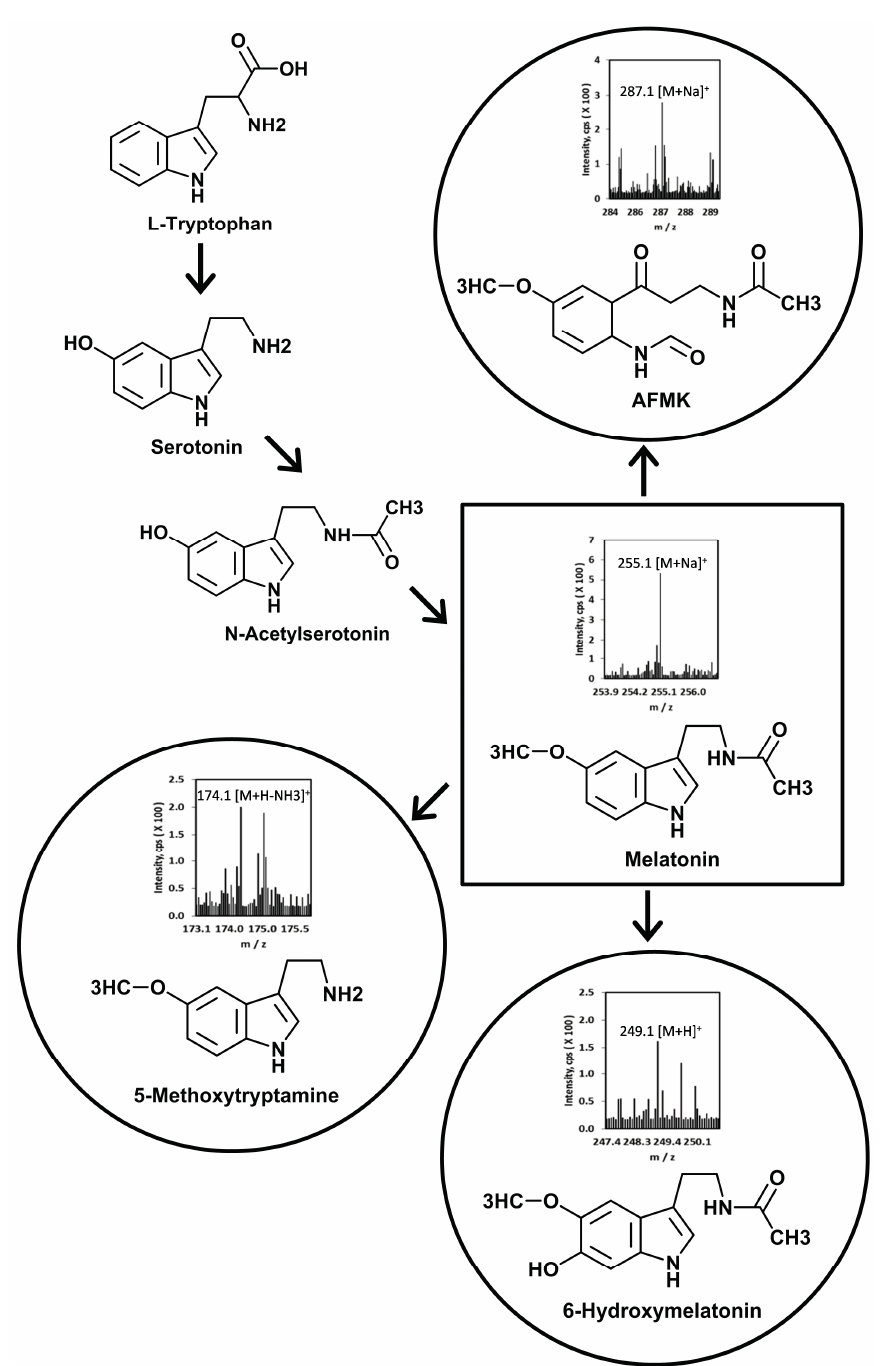
Figure 1. Scheme of cutaneous melatonin synthesis and metabolism. Mass spectra of melatonin metabolites are from separated fraction with retention times of the corresponding standards